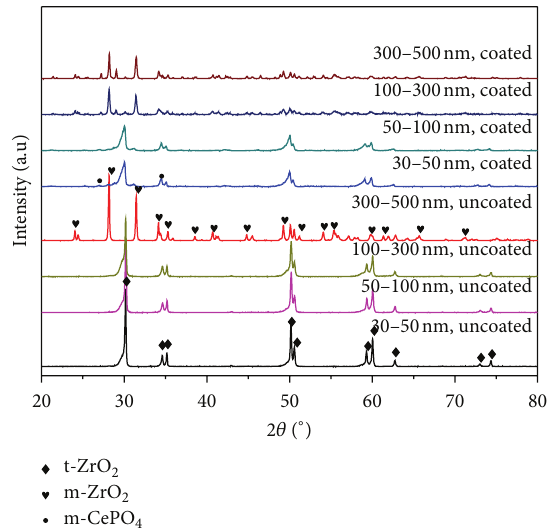
Figure 4: XRD patterns of the sintered 3Y-TZP